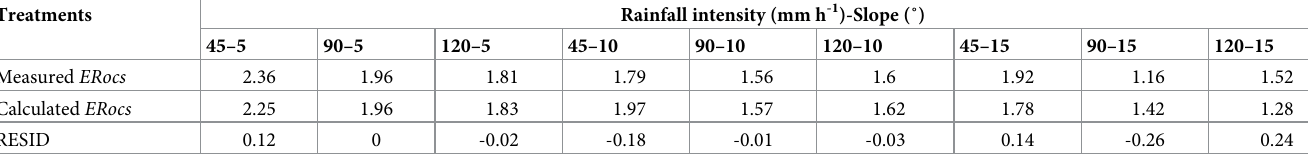
Table 8. Measured and calculated ERocs under different rainfall intensities and slopes. Treatments